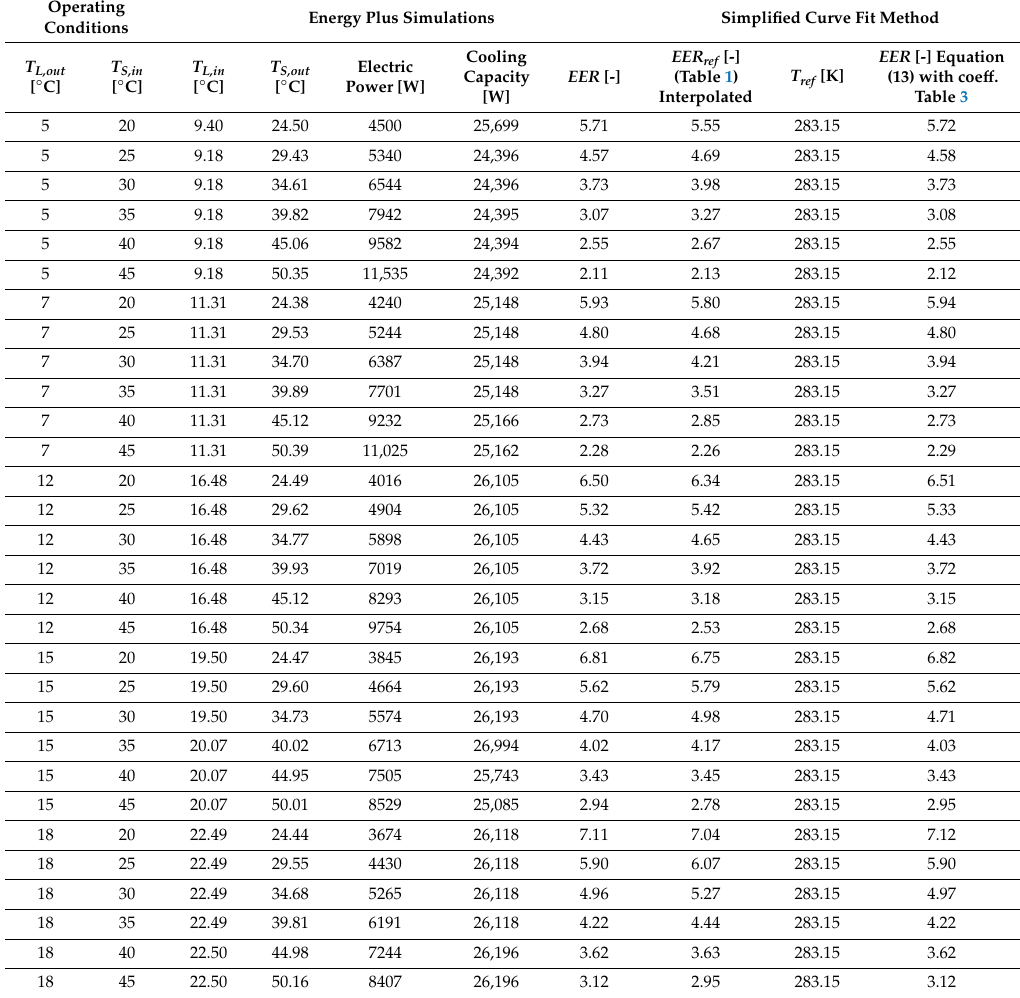
Table A1. Benchmark simulations for the water-to-water heat pump (cooling